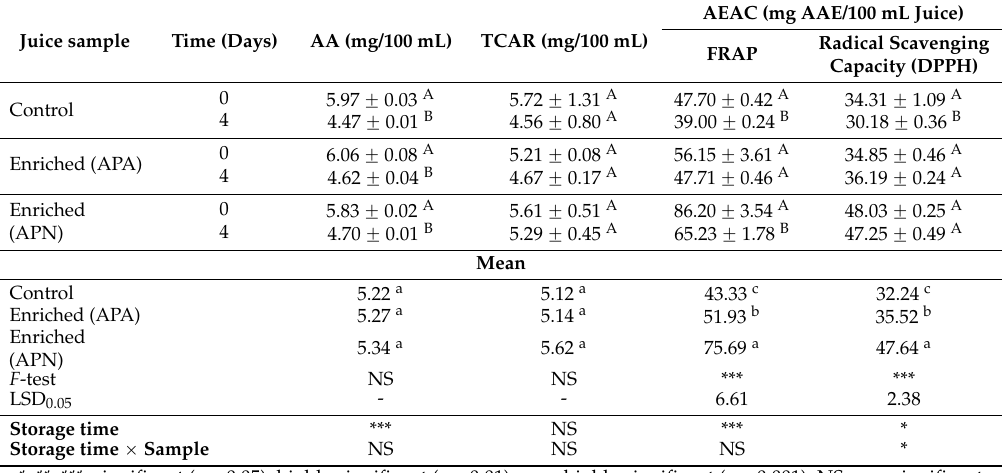
Table 3. Antioxidant components (AA; TCAR) and total antioxidant capacity (AEAC) of tomato juice compared to control before ( t 0 ) and after storage ( t 4